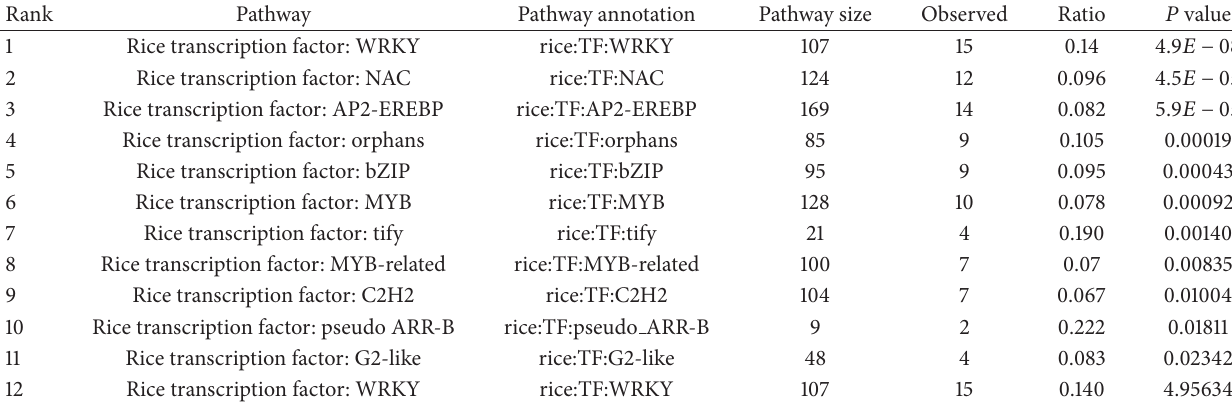
Table 3: Top ranked transcription factors that are regulated in rice by